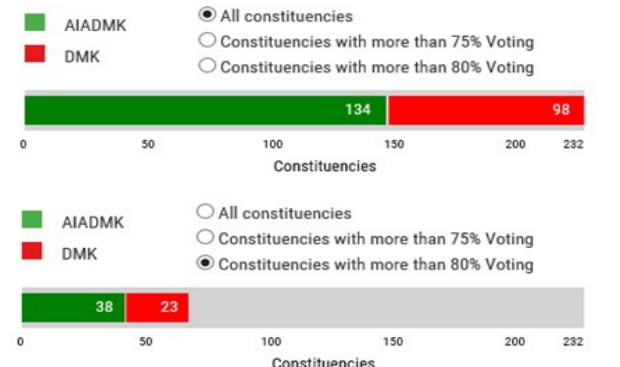
Figure 6: Anti-Incumbency Factor Using Color-Coded